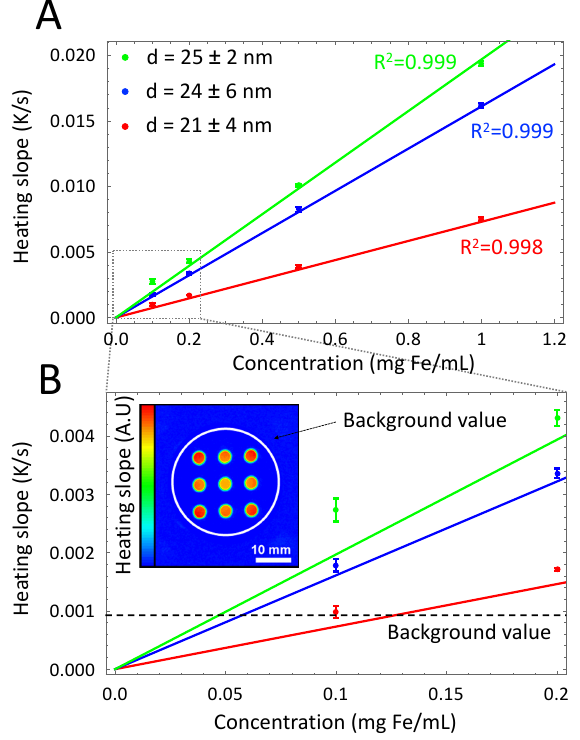
Figure 8. ( A ): Investigation of SPIONs with different size using measurements of the heating slope as a function of magnetic NP concentration for various sizes (triplicate experiment). Solid lines show best fit linear regression curves through the data. ( B ): Lower concentrations, approaching the limit of detection. In agreement with the model, the standard deviation increases at lower heating slopes. We plotted the value of the background that was previously used as limit of detection. Inset: Example of an Figure 2. Inhomogeneities in the alternating magnetic fi eld can be visualized by LIT. Magnetic fi eld inhomogeneities will unavoidably lead to heating slope image where the nine cuvettes are loaded with an identical sample. The homogeneous di ff erent results (e.g., while repositioning the sample). By using LIT, these variations can be visually rendered over the XY plane. This is done by loadingidenticalnanoparticlesolutionsinallsamplecuvettesandinvestigatingtheirthermalsignatures(A).Discrepanciesintheheatingpro fi les(B) background signal outside the cuvette area was previously used to estimate the minimal measurable are thus revealed, and are used to calculate the magnetic fi eld strength in the respective cuvettes (C). For variations in the Z axis, the procedure is repeated while gradually displacing the sample holder in the coil (D). In this case the fi eld is calculated at each height for the central cuvette. signal. Data taken with permission from